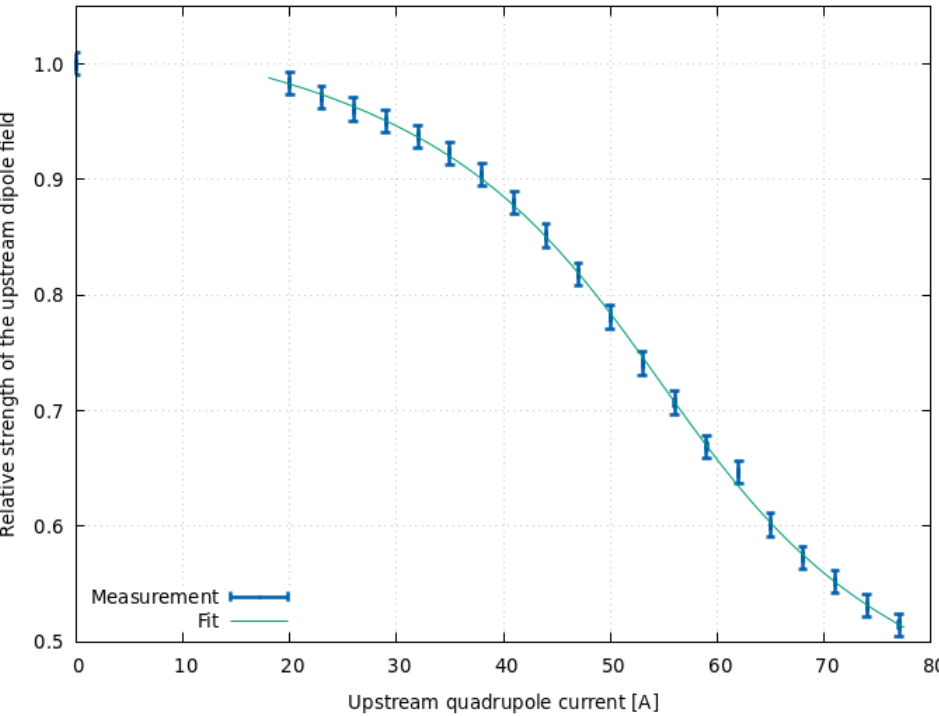
Figure 5. Relative strength of the upstream bending dipole as a function of the current in the upstream quadrupole.